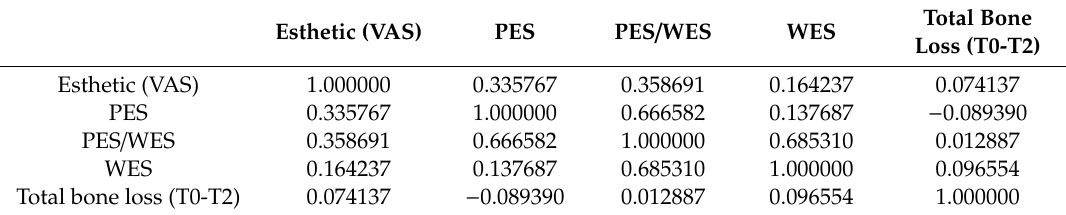
Table 7. Pearson’s Correlation Coe ffi